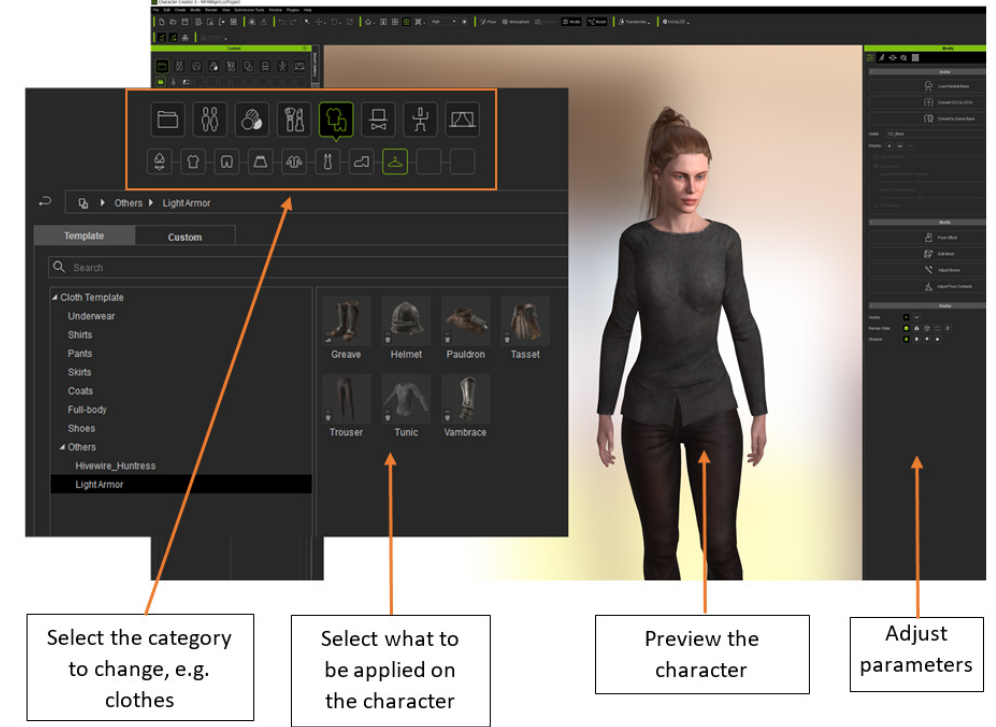
Figure 6. Character Creator 3 user interface and functionalities.